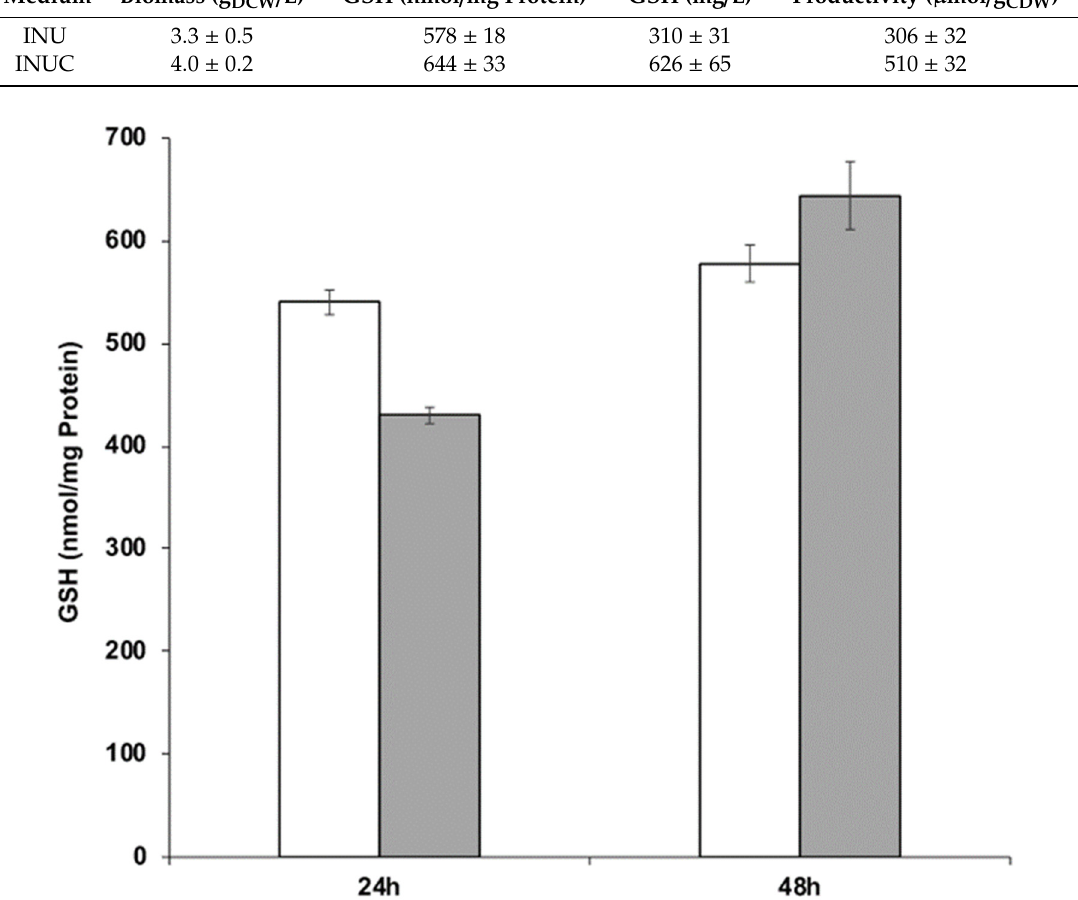
Figure 5. GSH production during the batch cultivation of the Y. lipolytica strain RIY389 (p TEF-ylGSH1-ylGSH2-INU1 ) in INU medium (white bars) and INUC medium (grey bars). The glutathione titer value was expressed in nmol per mg of protein (nmol/mg Protein). Data are the mean and standard deviation of two experiments.